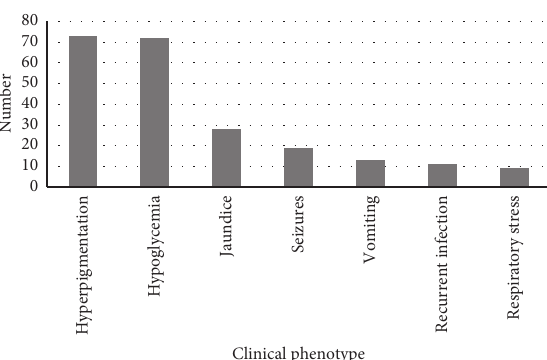
Figure 3: Frequency of the phenotypic characterization of the reported variants in the